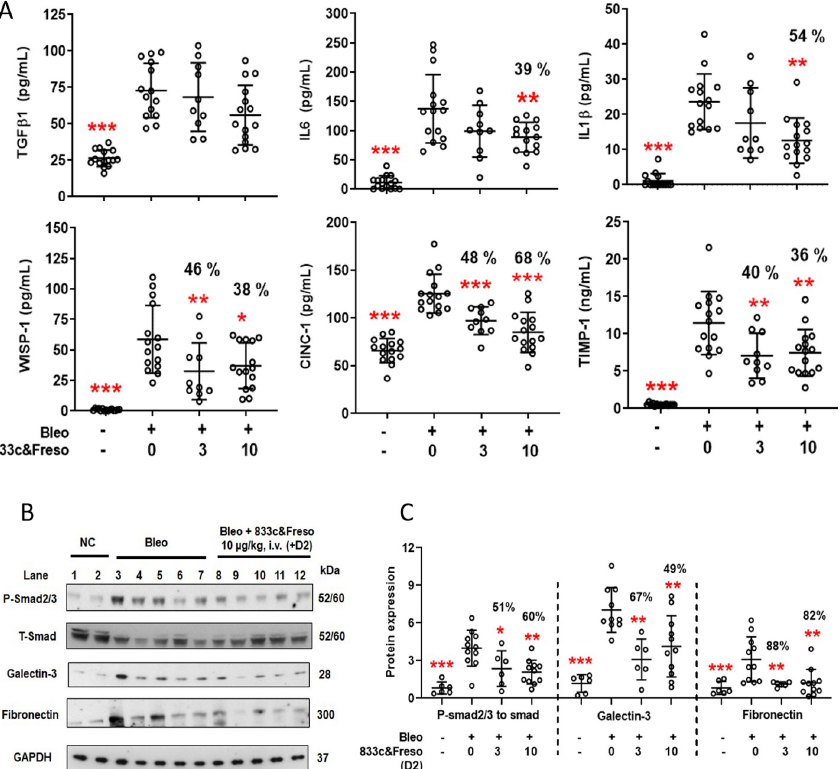
Fig 5. 833c&Freso reduces TGF- β -mediated disease biomarkers and signaling in the lung. Biochemical assays were performed on lung samples taken from untreated rats and rats treated as indicated with 833c&Freso on day 2 after bleomycin challenge. BALf or lung tissue was harvested on day 3. (A ) Concentration of the indicated biomarkers detected in BALf. Data pooled from 2–3 independent experiments with n = 10–15 total rats per group. (B) Western blot of lung tissue homogenates using antibodies to the indicated proteins. GAPDH: loading control. Data pooled from 2–3 independent experiments with n = 6–11 total rats per group. (C) Relative expression of indicated proteins derived from western blot image analysis. Smad 2/3 protein phosphorylation: ratio of P- to T Smad 2/3. Graphs show means ± SD. Percentage (%) inhibition of biomarkers in BALf (A) and proteins expressed in the lung (C) are shown. � P < 0.03, �� P < 0.01, and ��� P < 0.001 were obtained vs bleo control by one-way ANOVA followed by Dunnett’s test.